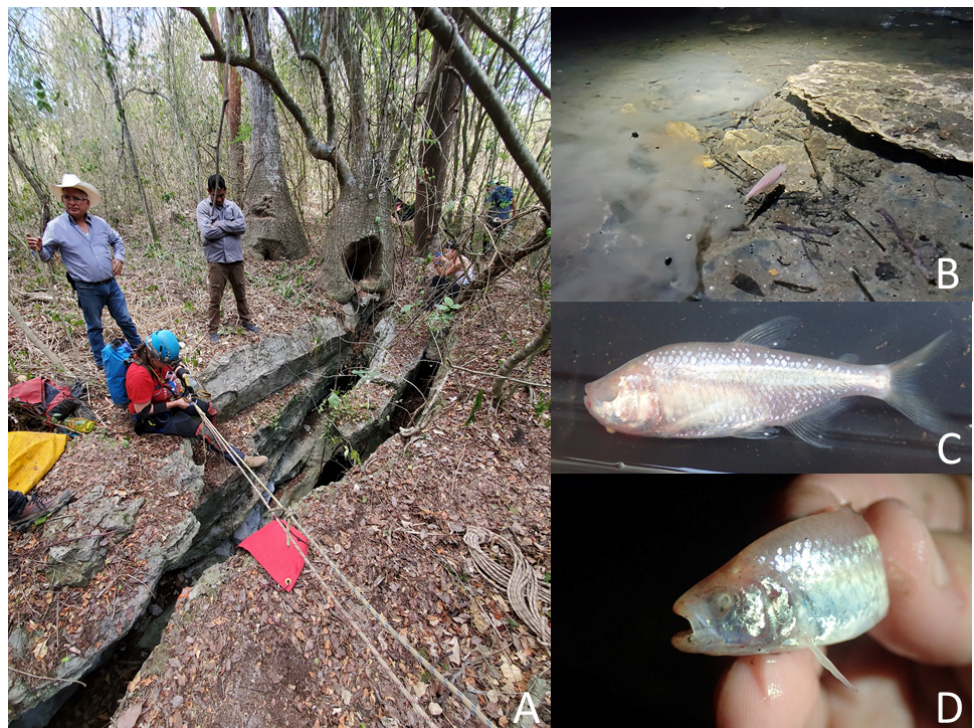
Diversity 2020 , 12 , x FOR PEER REVIEW